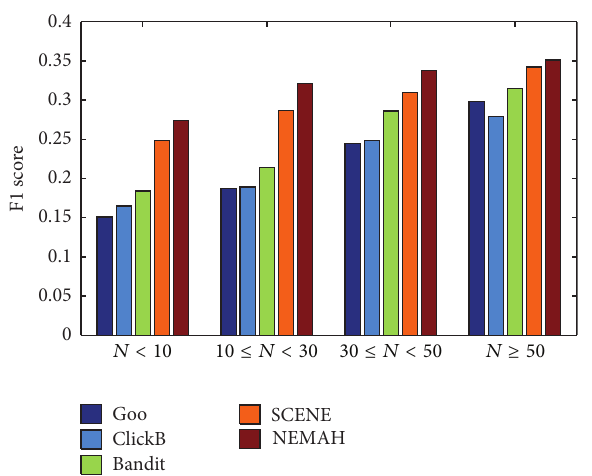
Figure 10: Comparison of F1 score of different approaches for different user groups. Remark . 𝑁 denotes the number of news articles per day which is read by a user.